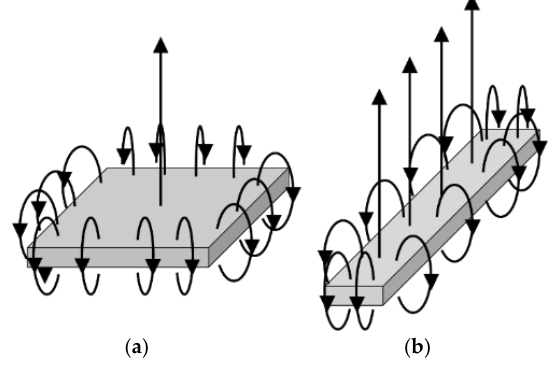
Figure 8. Magnetic field lines of square ( a ) and rectangular magnets ( b ). When an infinitely long rectangular magnet is used, the magnetic force line at its center is vertical.